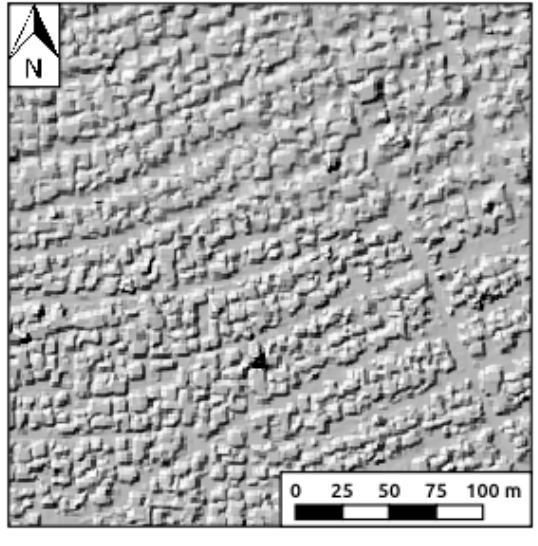
Figure 4. 1m DSM of Phomolong